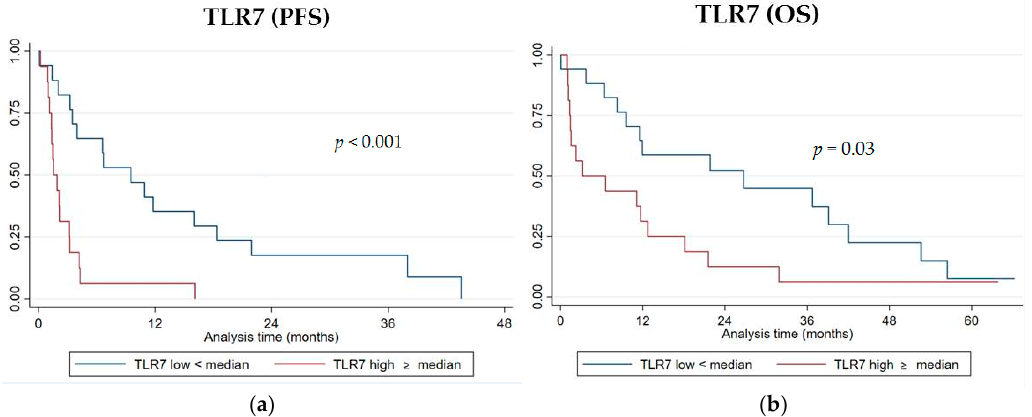
Figure 3. Kaplan–Meyer survival curves for progression-free survival (PFS) ( a ) and overall survival (OS) ( b ) according to TLR7 gene expression.